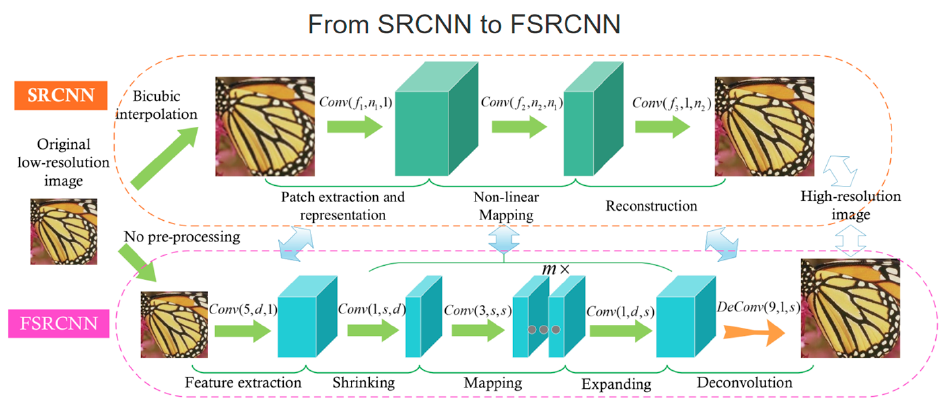
Figure 1. Super-resolution convolution neural network (SRCNN) model structure.